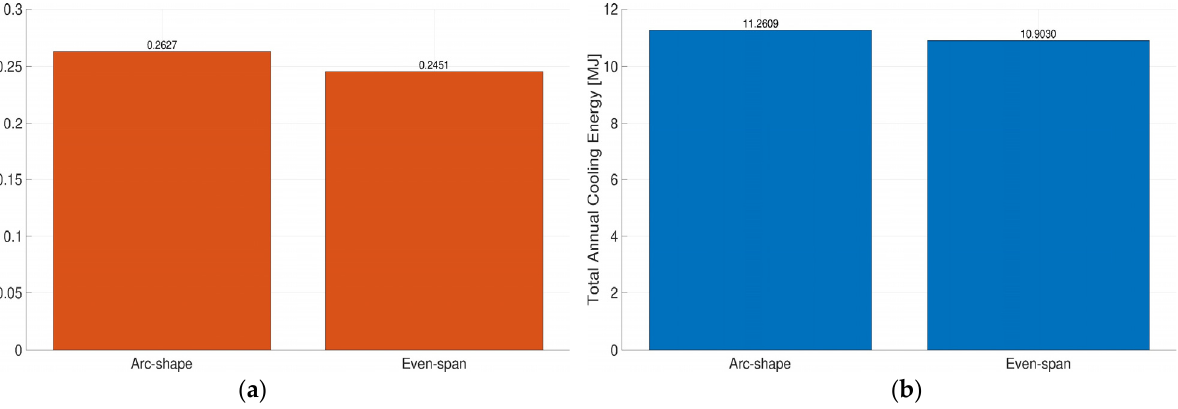
Figure 8. Ideal annual energy required for ( a ) heating and ( b ) cooling for the different orientations (using PC sheet (air-gap 9.2 mm) as the glazing material with an Even-Span shape)).